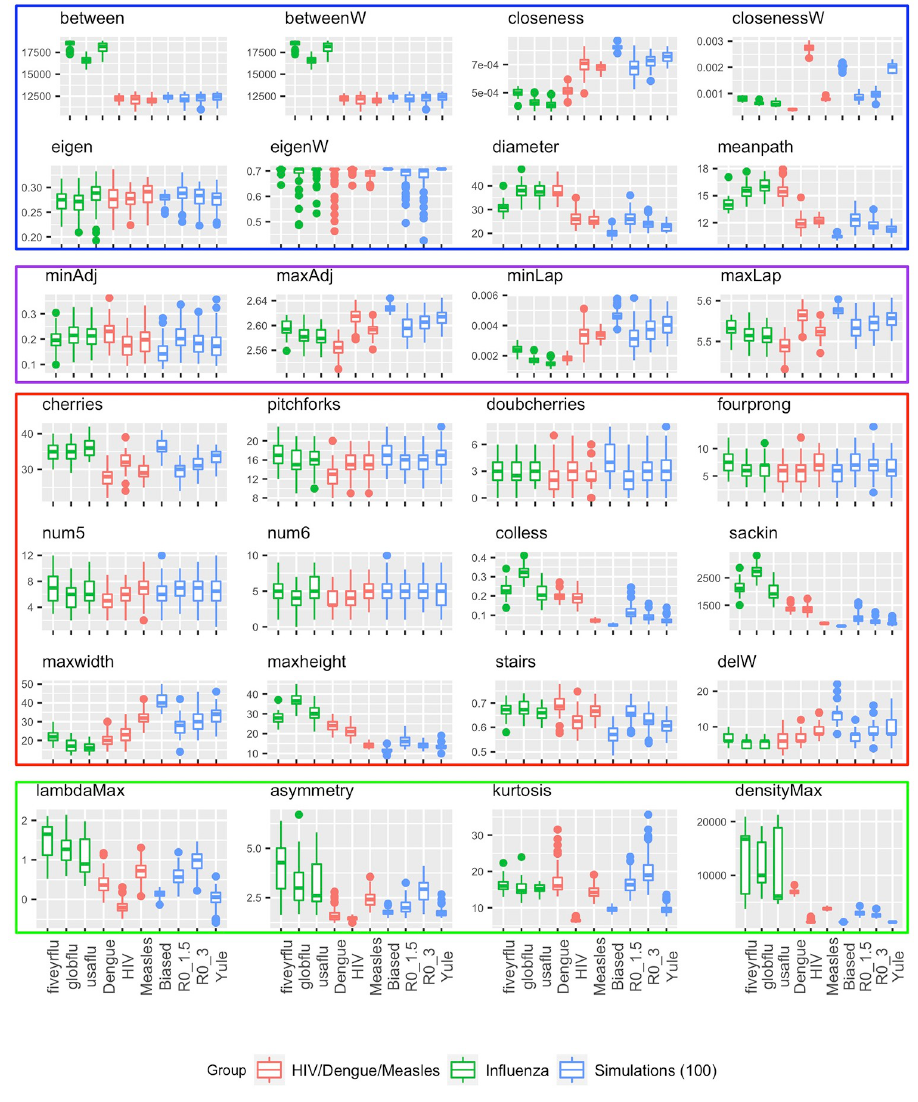
Fig 2. Tree summaries for the HIV/Dengue/Measles, influenza and simulations of size 100.